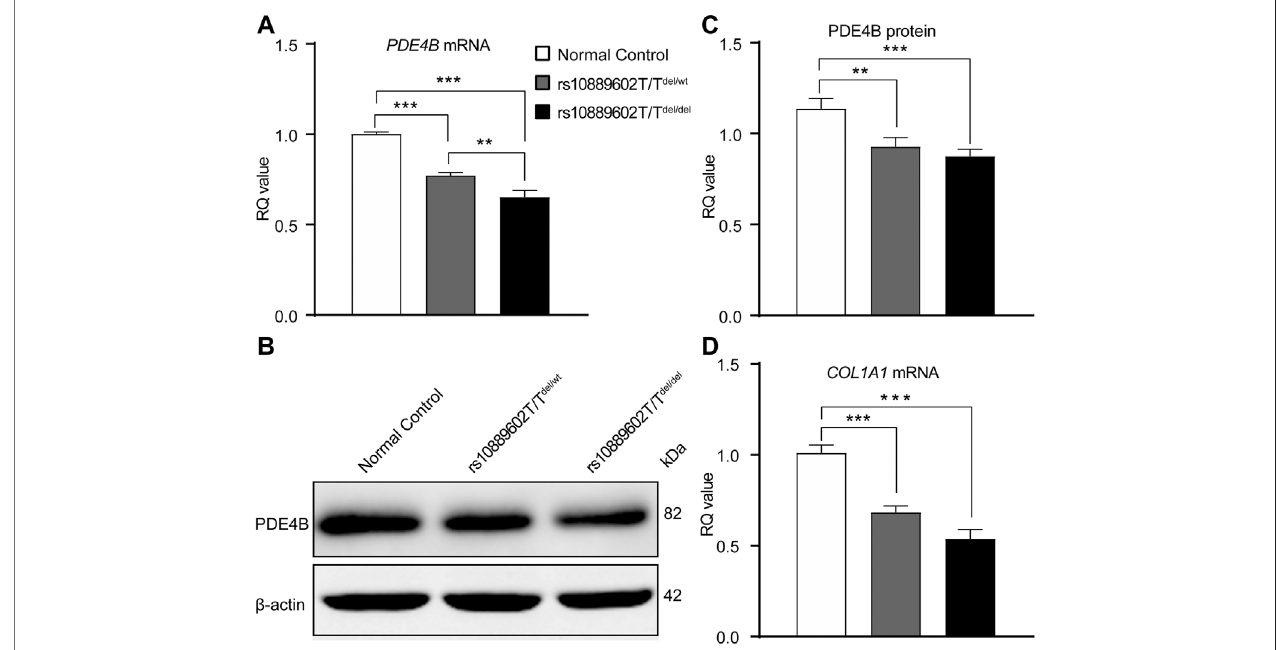
FIGURE4| Rs10889602T/TSNP deletion inA549cellsdecreases PDE4Band COL1A1mRNA and/or protein expression levels. (A) qRT-PCRanalysisof PDE4B mRNA expression levels. GAPDH was the loading control. (B) Western blot analysis of PDE4B protein expression levels, β -actin was the loading control. (C) Densitometric quanti fi cation of western blot results of PDE4B expression levels. (D) qRT-PCR analysis of COL1A1 mRNA expression levels, GAPDH was the loading control. Data are expressed as mean ± standard error (mean ± SEM), n (cid:1) 6 for each group, multiple comparisons of different A549 cell lines were done using the one-way ANOVA with Bonferroni post hoc test. p -value < 0.05 was considered statistically signi fi cant (** p < 0.01 and *** p < 0.001). qRT-PCR, quantitative real-time polymerase chain reaction; GAPDH , glyceraldehyde-3-phosphate dehydrogenase; RQ, relative